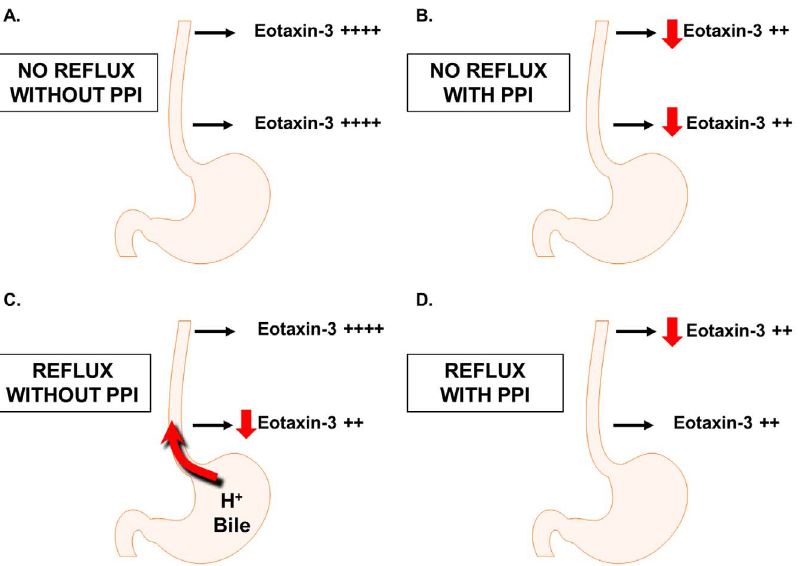
Figure 9. Conceptual summary of invitro findings. (A) In patients with Th2-cytokine driven esophageal eosinophilia who have little or no reflux, epithelial cell expression of eotaxin-3 will be high in both the proximal and distal esophagus. (B) When patients without reflux are given PPIs, epithelial cells in both the proximal and distal esophagus can respond to the acid-independent, anti-inflammatory effects, which decrease eotaxin-3 expression in both locations. (C) For patients who have Th2-cytokine driven esophageal eosinophilia and gastroesophageal reflux, eotaxin-3 expression in the distal esophagus might be suppressed by reflux, while eotaxin-3 expression remains high in the proximal esophagus where reflux exposure is minimal. (D) When patients with reflux are treated with PPIs, the proximal esophagus responds to the acid-independent, anti- inflammatory PPI effects in suppressing eotaxin-3. In the distal esophagus, however, refluxed acid already might be suppressing eotaxin-3 expression. PPI antisecretory effects could increase cytokine-stimulated eotaxin-3 expression by decreasing acid reflux, while PPI anti-inflammatory effects could decrease eotaxin-3 expression. Thus, PPI treatment might have little net effect on eotaxin-3 expression in the distal esophagus.